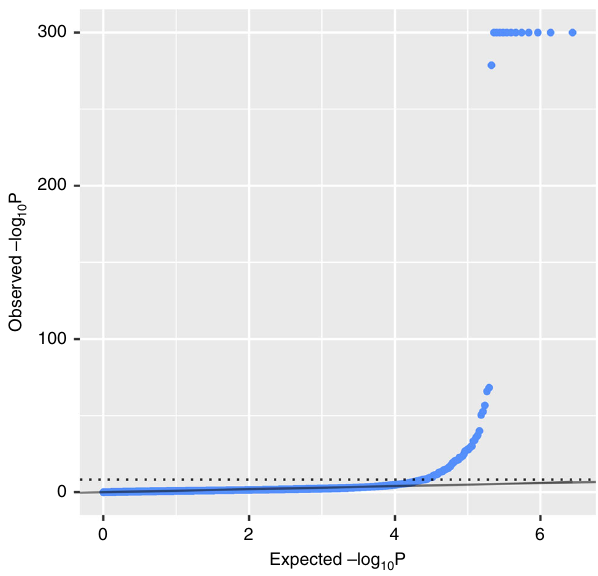
Fig. 1 A quantile – quantile plot shows the observed ( y -axis, − log10 scale) and expected p -values ( x -axis, − log10 scale) for each transcript pair in the analysis (2 755 498) as determined by a χ 2 test. The dotted line marks the multiple testing threshold (Bonferroni: p < 1.81×10 − 8 ), which includes 556 transcript pairs. Of these signi fi cant transcript pairs, 77.0% are located on different